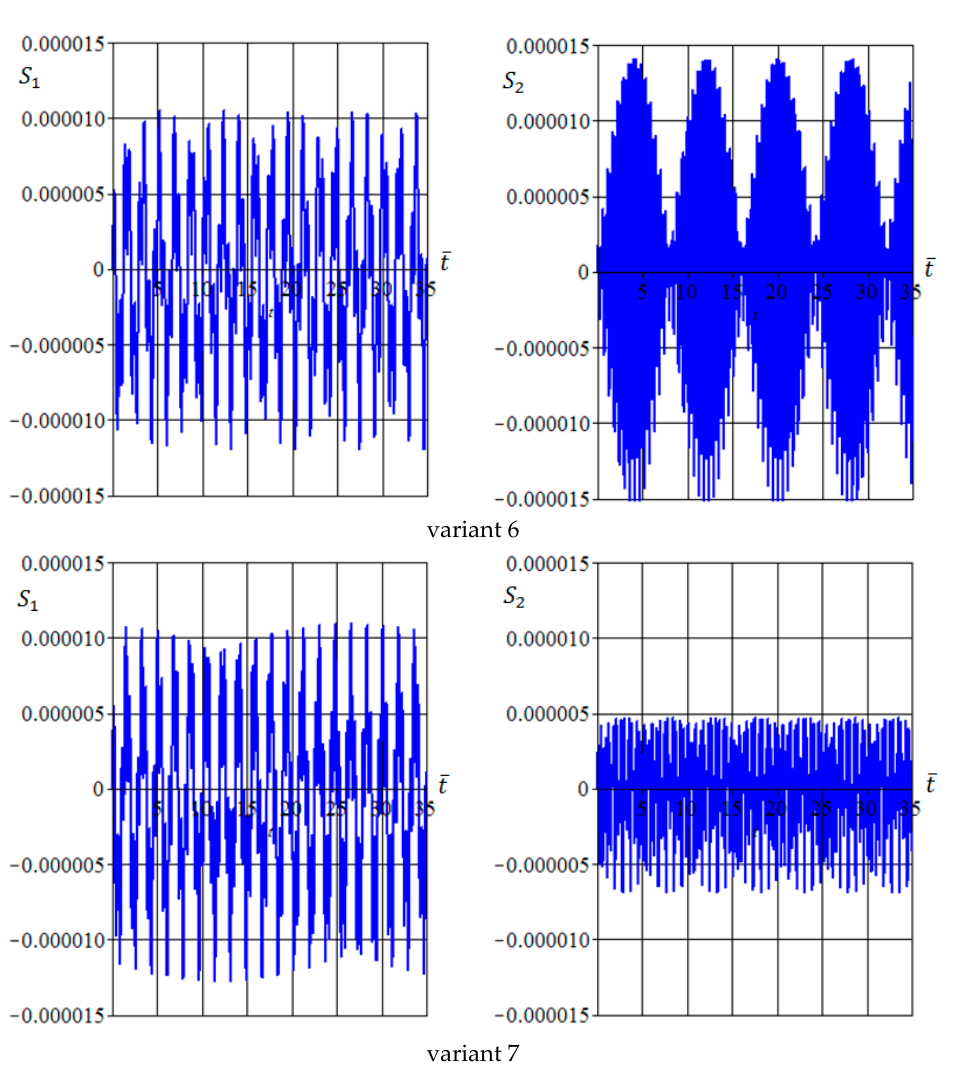
Figure 13. Functions S 1 ( t ) ( left column ) and S 2 ( t ) ( right column ) for different γ values (variant